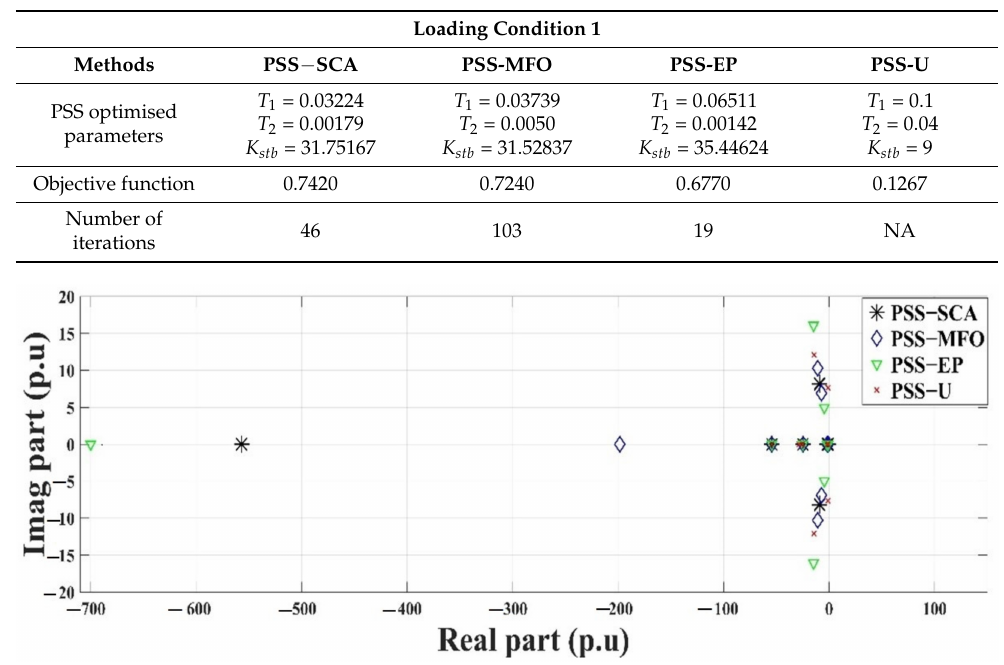
Figure 6. Eigenvalue’s location on the complex s-plane for loading condition 1 of the SMIB with PSS.